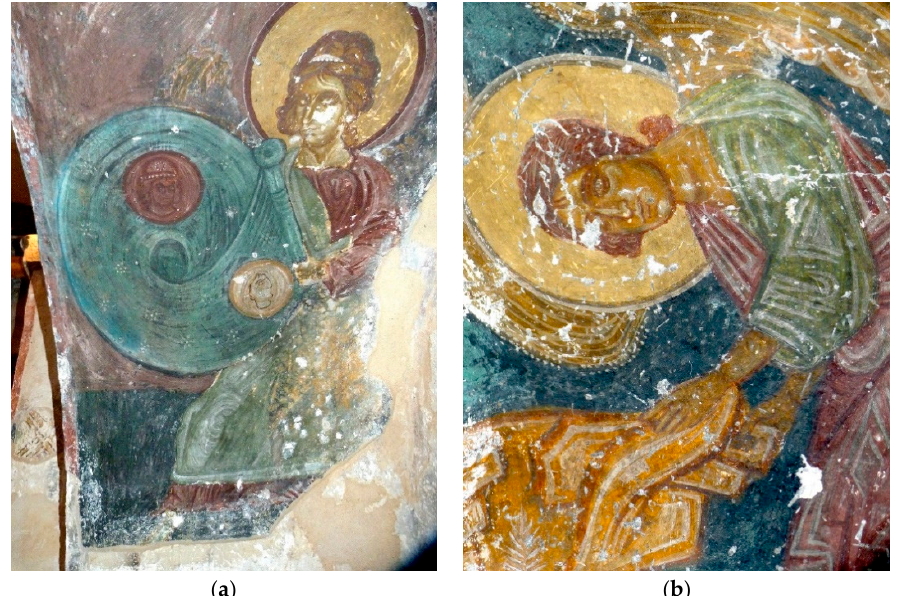
Figure 16. Apocalyptic angels (Rev 6, 12–14) in the intrados of arcosolium (1311), Hagios Georgios in Akraifnio (Karditsa, Boeotia, Greece), south wall of the crossing. ( a ) Angel rolling up the heavens. ( b ) Angel removing the mountains. © Author with the permission of the Ephorate of Antiquities of Boeotia.